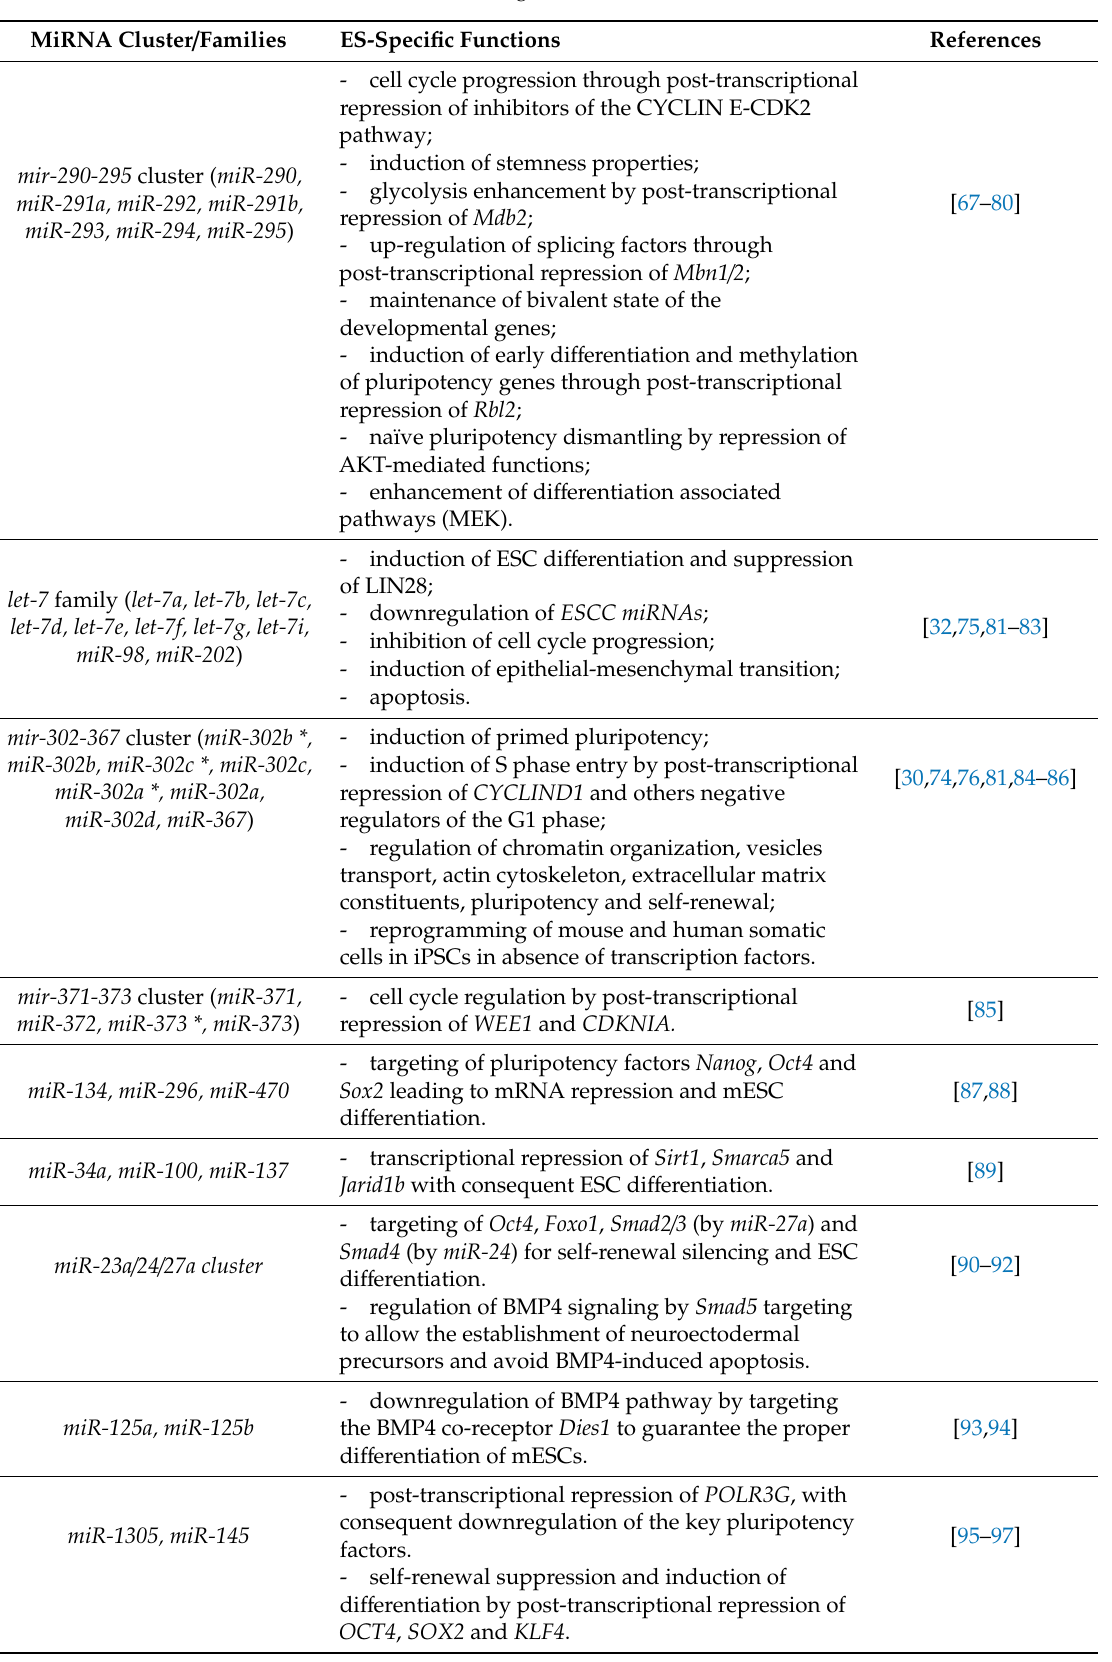
Table 1. Main microRNAs acting in ESCs and their relative